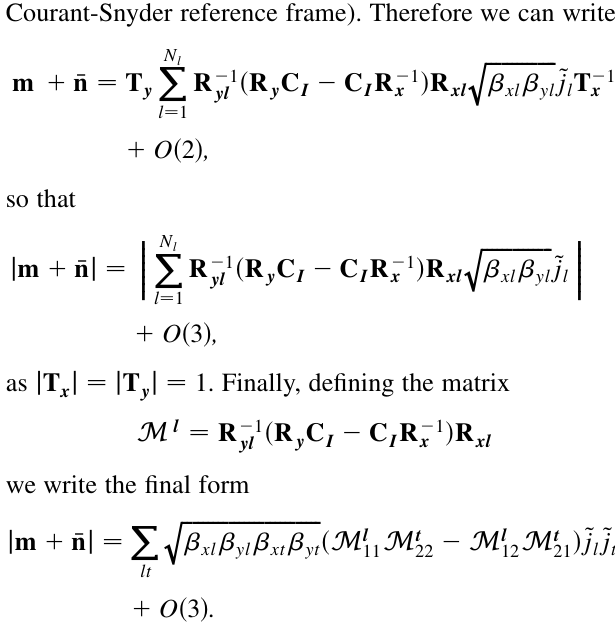
ffiffiffiffiffiffiffiffiffiffiffiffiffiffiffiffiffiffiffiffiffiffiffiffiffiffiffiffiffi (cid:3) (cid:3) (cid:3) (cid:3) xl yl xq yq